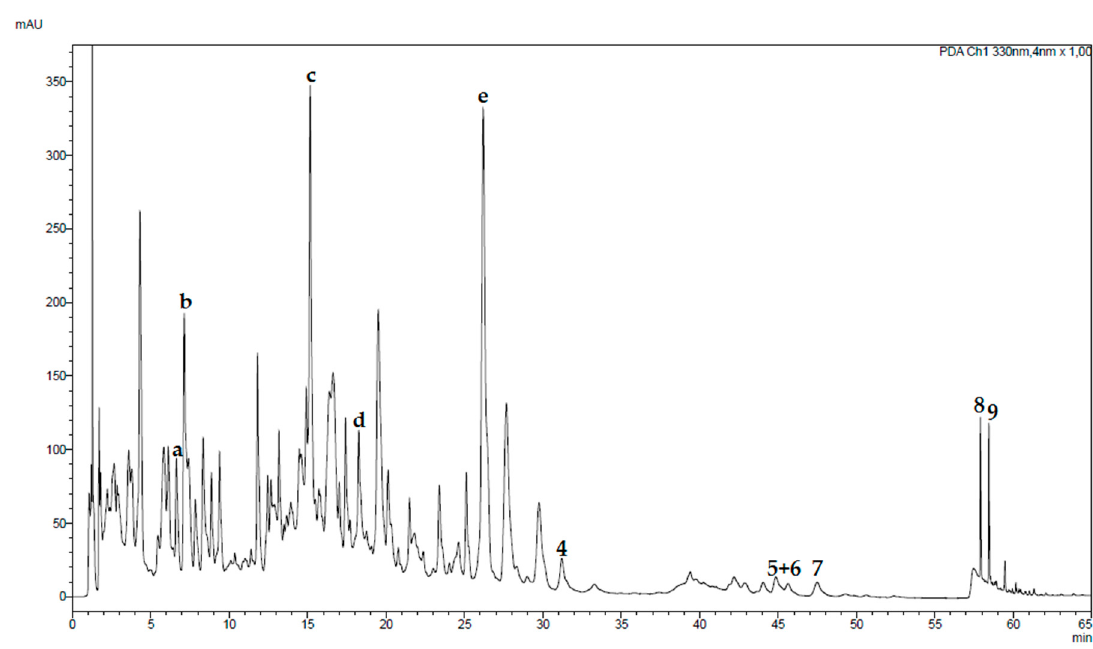
Figure 7. Chromatogram of a liquor prepared from T. diffusa . UHPLC was performed using a solvent mixture of 0.1% formic acid in water (solvent A) and acetonitrile (solvent B) with the following gradient: 15% B to 25% B in 15 min, to 29% B in 9 min, to 29% B in 11 min, to 36% B in 1 min, to 36% B in 19 min, to 95% B in 0.1 min, to 95% B in 9.9 min. Post-run was set to 10 min, temperature to 32 ◦ C. The injection volume was 5 µ L. The ultraviolet (UV) trace was recorded at 330 nm. The flow was 0.2 mL/min. 4 to 9 refer to the isolated compounds (see Figure 1), compounds a to d were identified by UV spectroscopy and MS spectrometry experiments as larycitrin-3- O -(6-glucosyl)glucoside ( a ), apigenin 8- C -(2-rhamnosyl)glucoside ( b ), (luteolin 8- C -(2-rhamnosyl)ketodeoxihexoside ( c ), apigenin 7- O -(2-rhamnosyl)ketodeoxihexoside ( d ), and e was identified as apigenin by an authentic standard.